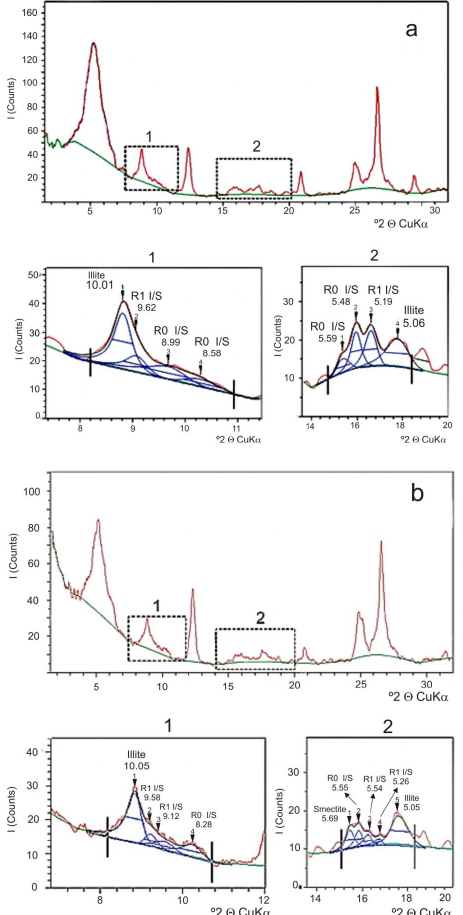
XRD, blue lines are deconvoluted peaks and black line represents the sum of deconvoluted peaks. Deconvoluted peaks are represented in d values in Å noted above the peaks which allow the determination of R type and percent illite according to